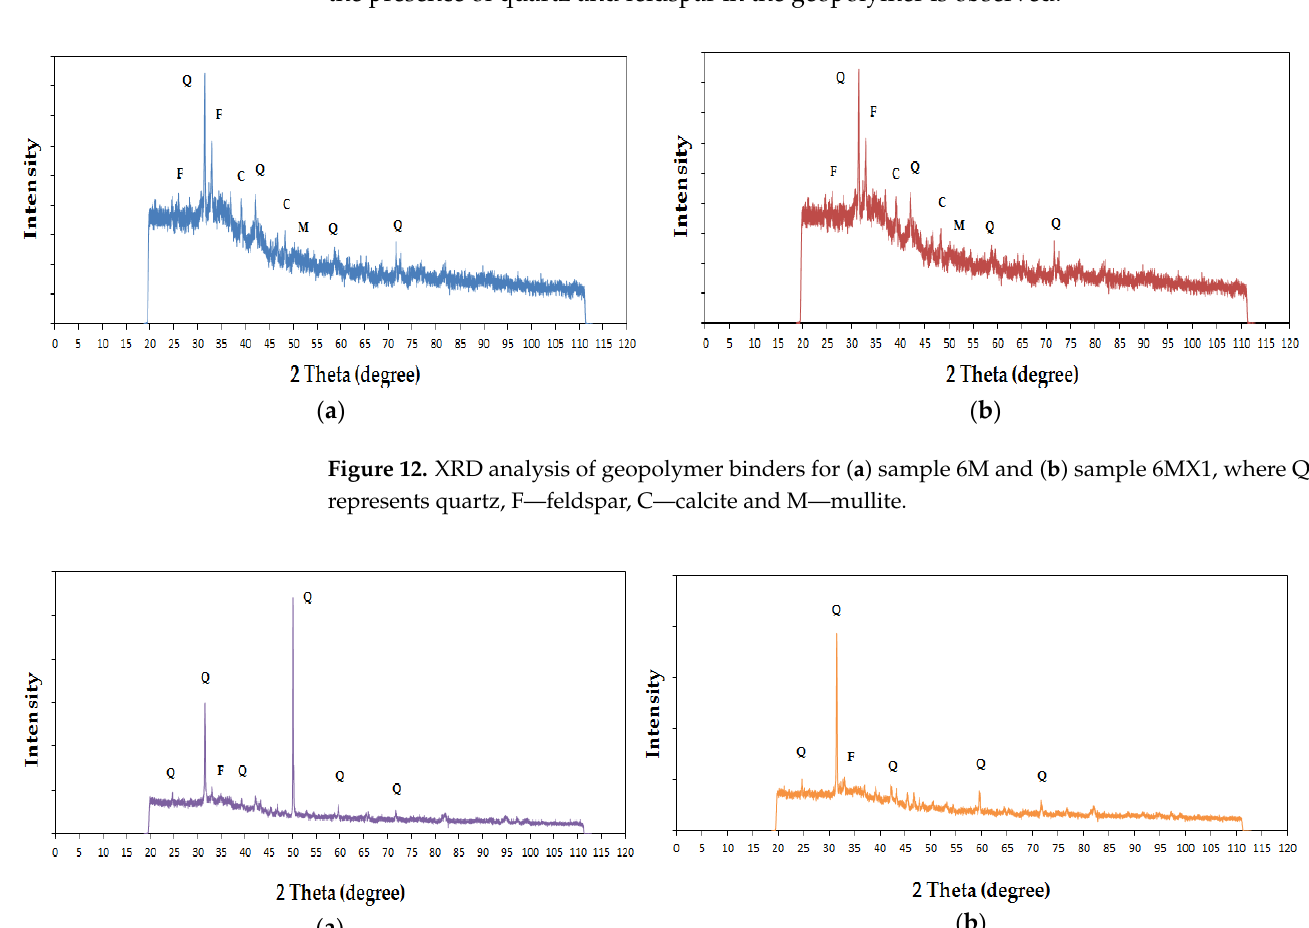
Figure 13. XRD analysis of geopolymer binders for ( a ) sample 8M and ( b ) sample 8MX1, where Q represents quartz, F — feldspar.